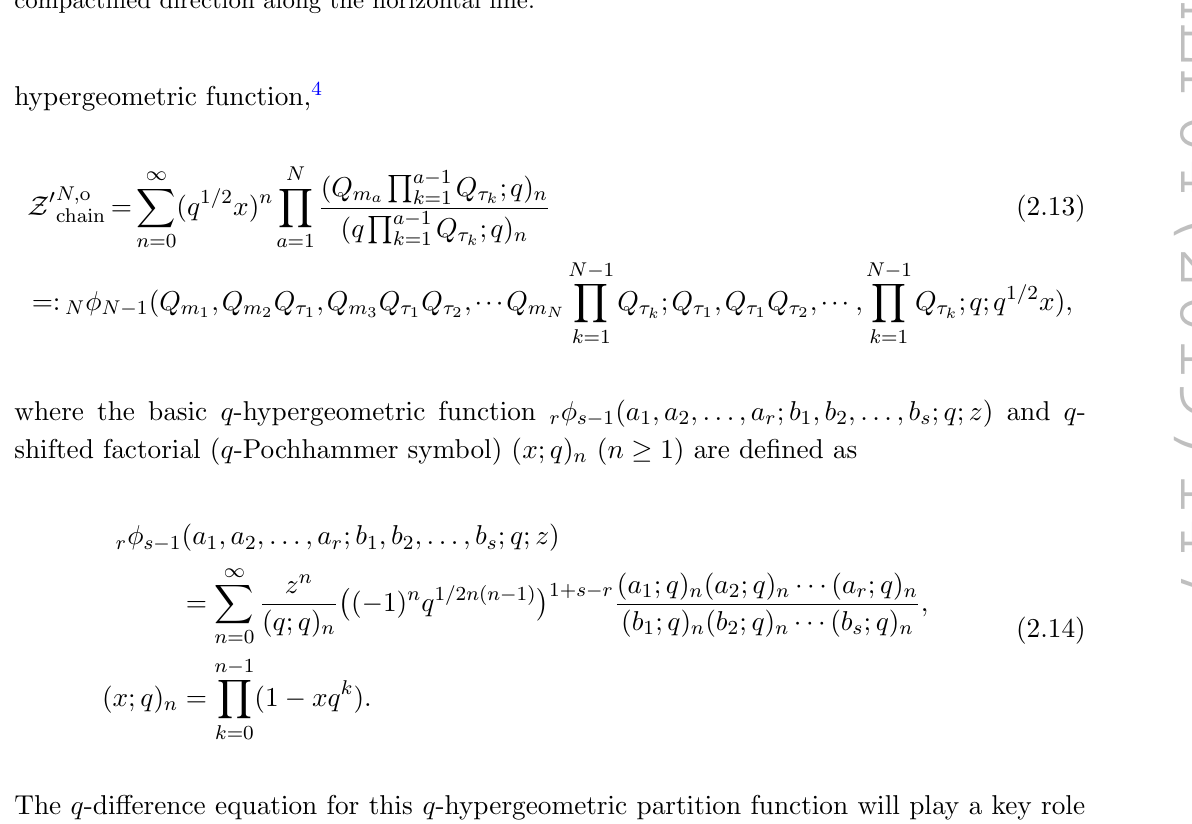
Figure 3 . The periodic N -chain geometry with the branes. Compared with (cid:12)gure 2, there is compacti(cid:12)ed direction along the horizontal